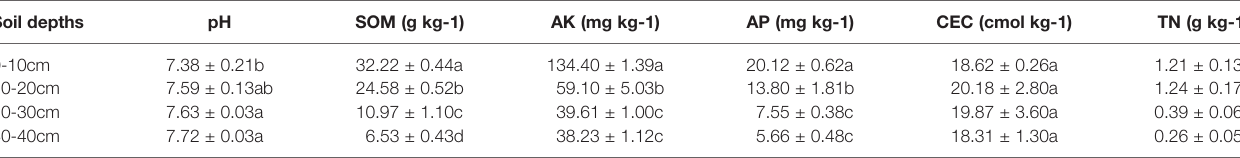
TABLE 2 | Basical characteristics of the pro fi le (0-40cm) soils fi lled in column in the present study. Soil depths pH SOM (g kg-1)